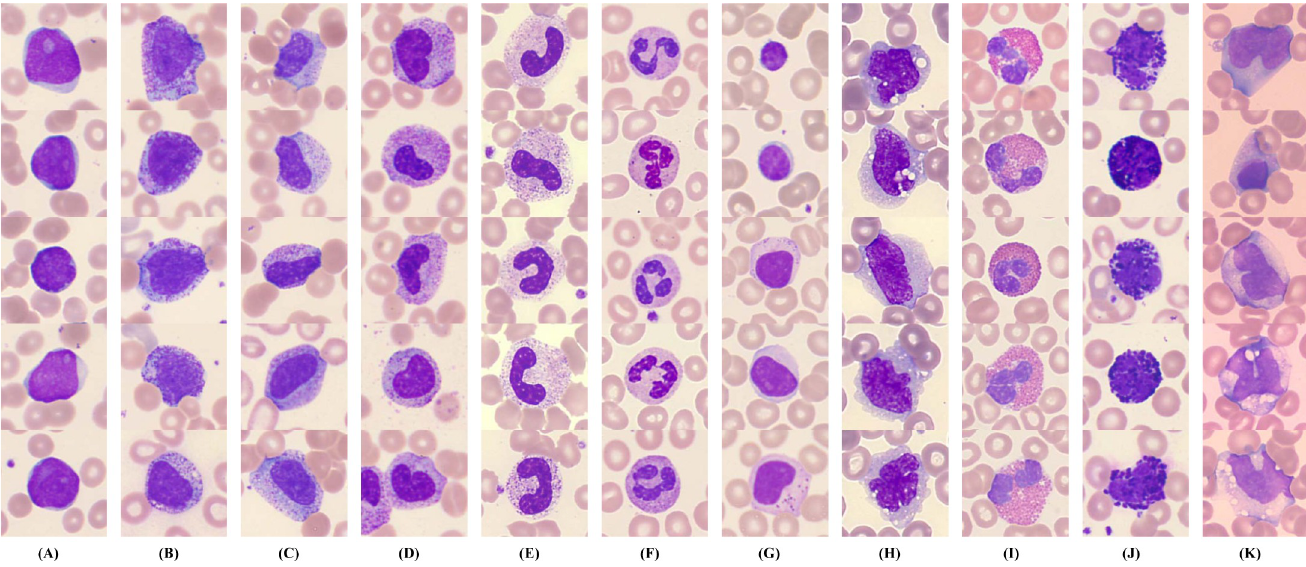
Fig 2. Selected samples of peripheral leukocytes. (A) blast; (B) promyelocyte; (C) myelocyte; (D) metamyelocyte; (E) band neutrophil; (F) segmented neutrophil; (G) lymphocyte; (H) monocyte; (I) eosinophil; (J) basophil; (K) reactive lymphocyte.